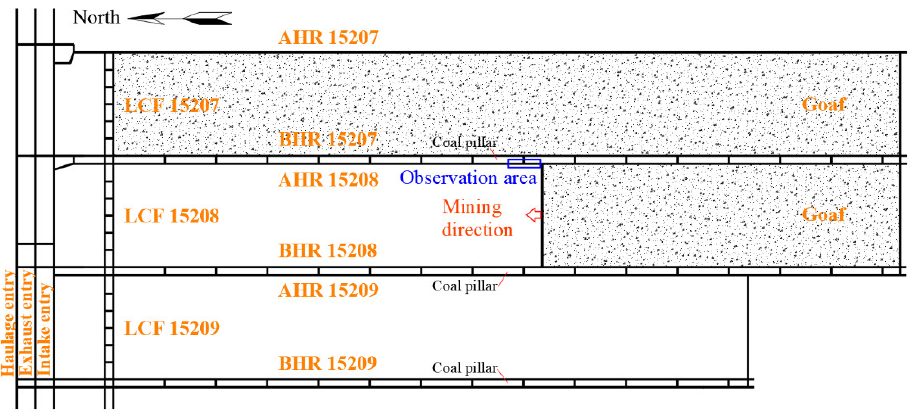
Figure 1. Mining layout of the Zhangjiamao Coal Mine.